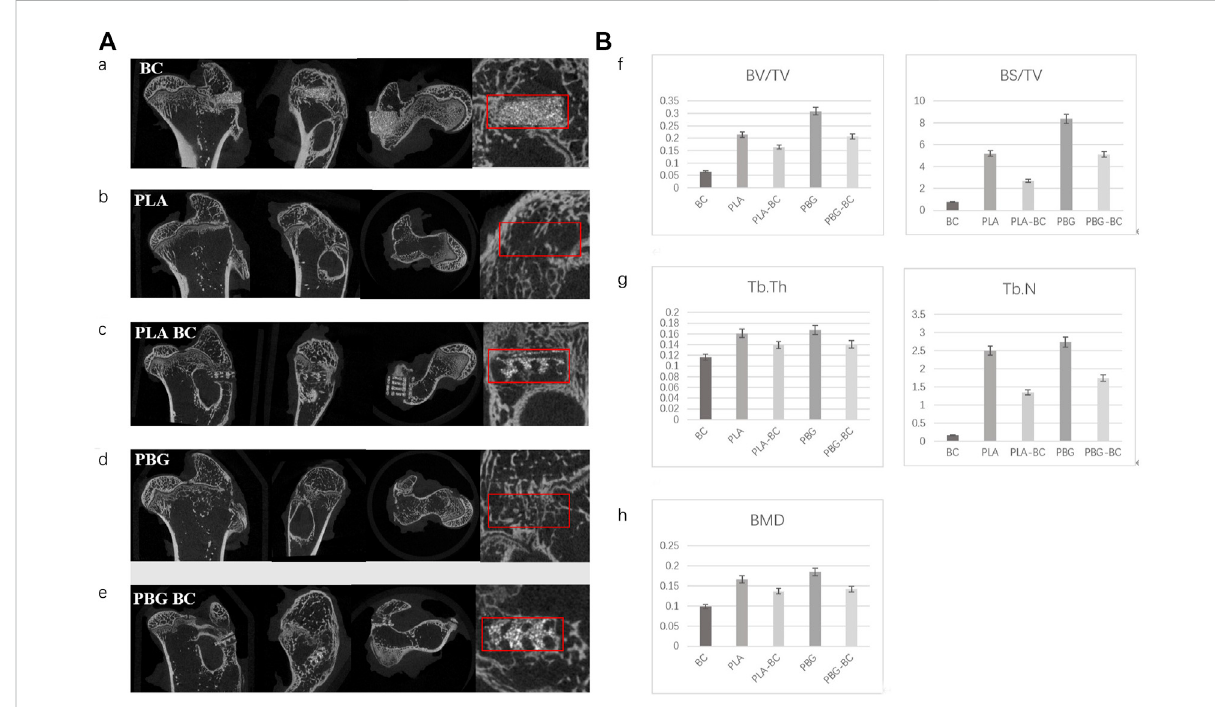
FIGURE 14 (A) . Coronal, sagittal, cross-sectional, and local enlarged images of micro-CT 12 weeks after sample implantation. a: BC, b: PLA, c: PLA-BC; d: PBG; and e: PBG-BC. (B) . Statistical comparative analysis of local area (2 mm × 2 mm ×1 mm around the stent) of micro-CT 12 weeks after